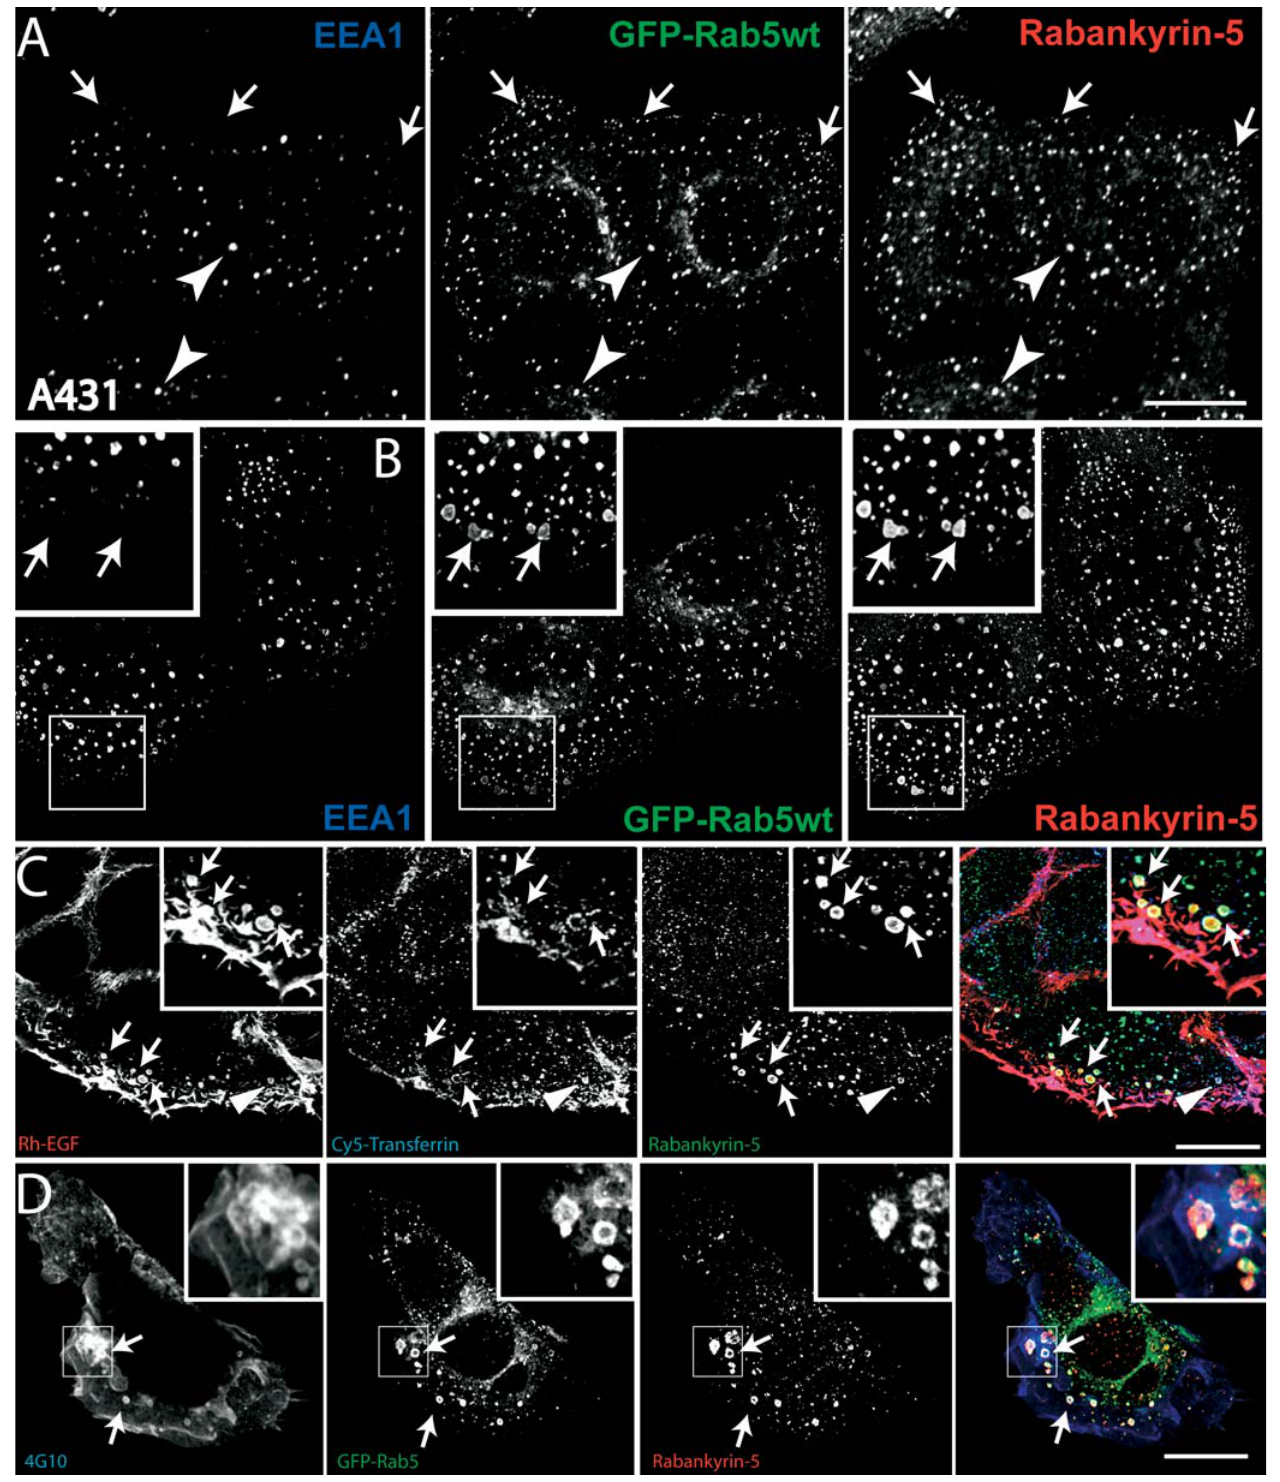
Figure 3. Rabankyrin-5 Associates with Two Types of Rab5-Containing Vesicles in A431 Cells, Early Endosomes, and Macropinosomes (A) A431 cells stably transfected for GFP-Rab5wt were immunostained for endogenous Rabankyrin-5 and EEA1. While there is perinuclear overlap between Rab5, Rabankyrin-5, and EEA1 in nontransfected cells (arrowheads), some smaller peripheral structures are devoid of EEA1 (arrows). (B) Overexpression of Rabankyrin-5 in A431 by using a recombinant adenovirus construct of Rabankyrin-5 causes an accumulation of peripheral, enlarged Rab5-positive structures, costained mainly by Rabankyrin-5 (arrows) but not detectable for EEA1. (C) Rabankyrin-5 localises on EGF-induced and -enriched macropinosomes. Serum-starved A431 cells (16 h) were incubated for 7 min with 100 ng/ml rhodamine-conjugated EGF to induce macropinocytosis and 1 l g/ml Cy5-labelled transferrin. Endogenous Rabankyrin-5 localises to